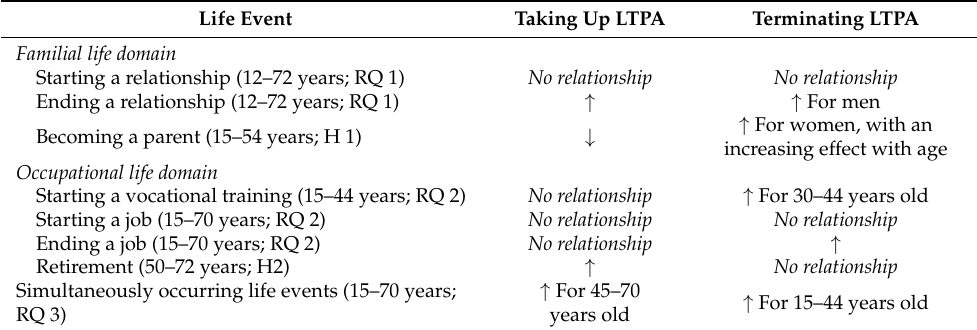
Table 4. Summary of results for the relationship between life events and taking up or terminating